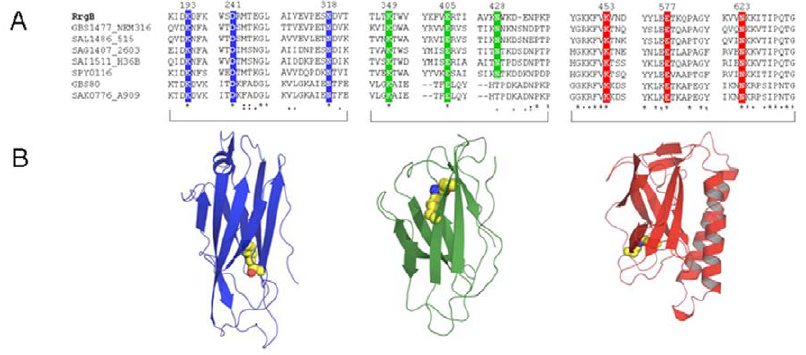
Figure 5. Sequence alignments of related pili proteins from Gram-positive bacteria. A) Sequence alignment showing intra-molecular isopeptide bond formation which involves conserved residues Lysine (K), Aspartic Acid (D), Glutamic Acid (E) and Asparagine (N). Residues are highlighted and coloured according to the domain localization. UniProtKB/TrEMBL accession codes are shown; RrgB-TIGR4, RrgB-6BSP and RrgB- 23FTW represent the sequences of the three RrgB alleles of S. pneumoniae ; SAG0645 (also known as GBS80) belongs to PI-1 of Streptococcus agalactiae ; GBS1477, SAL1486, SAG1407 and SAI1511 belong to GBS PI-2a, whereas SAK0776 belongs to GBS PI-2b; Spy0116 belongs to the M4 serotype of Streptococcus pyogenes . The sequence alignment was obtained and edited by Jalview/ClustalW [55]. B) Cartoon representation of RrgB single domains coloured as in 1A) is shown on the bottom. Yellow spheres depict the residues forming the isopeptide bonds.